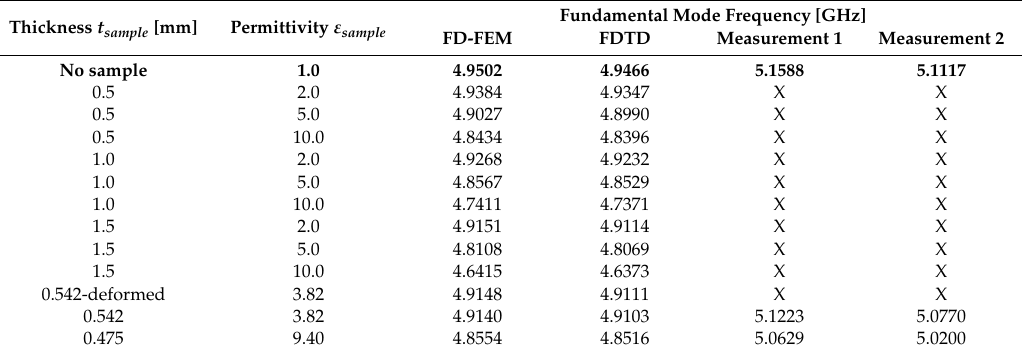
Table 1. Resonant frequency of the fundamental mode of SPDR loaded with dielectric samples varying in thickness and permittivity: simulations and measurements performed by the authors.